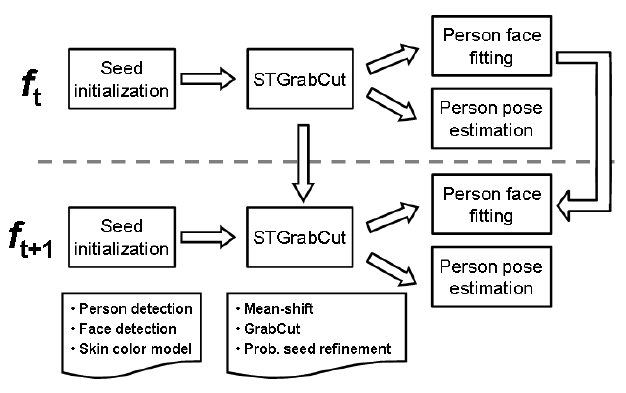
Figure 1. Overall block diagram of the